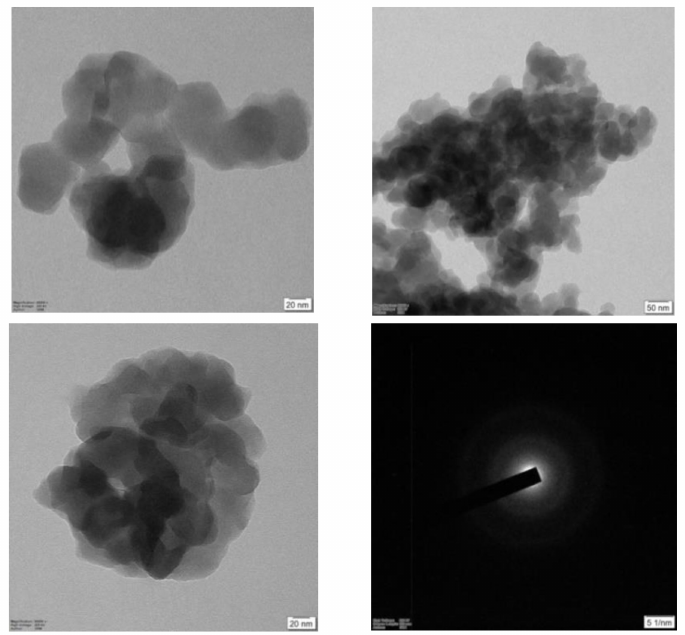
Figure 2. Transmission electron microscopy (TEM) images of the synthesized copper nanoparticles.